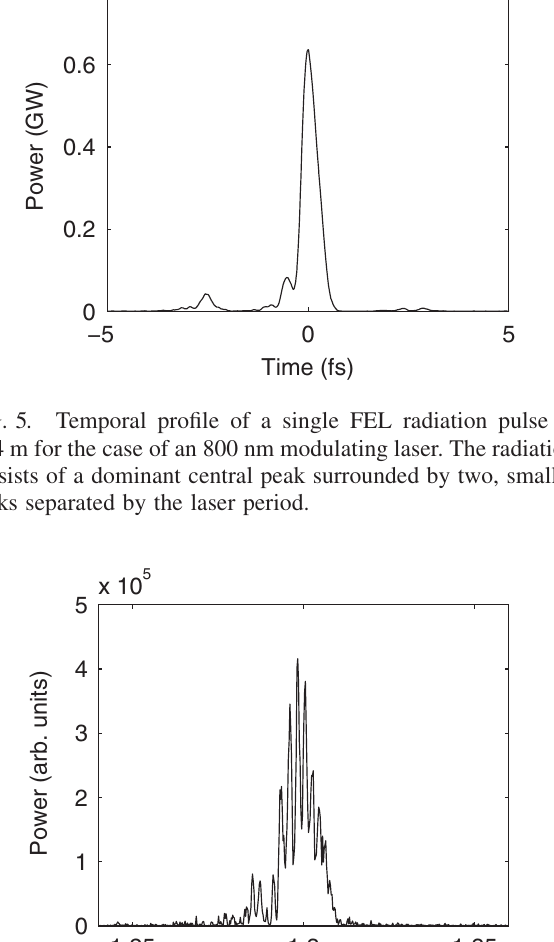
FIG. 8. Wigner transform of the radiation field at 34.4 m for the 800 nm modulating laser case. The pulse has been filtered and compressed to maximize the peak power and remove radia- tion emitted upstream.